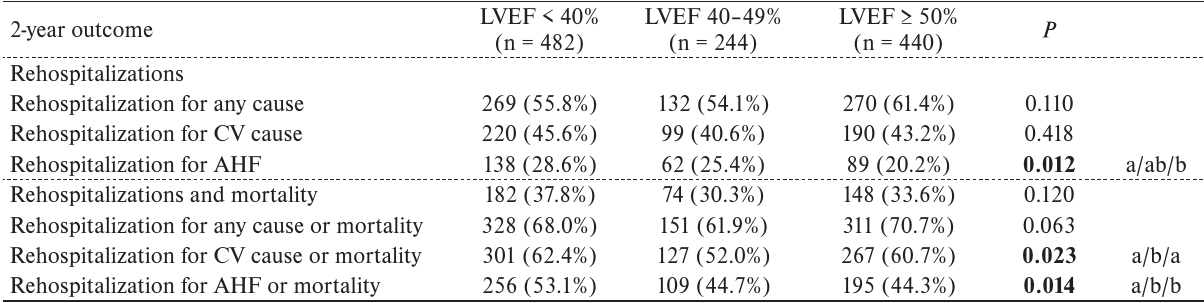
Table 5. Rehospitalization & mortality within 2 years after discharge from index acute heart failure hospitalization, stratified by